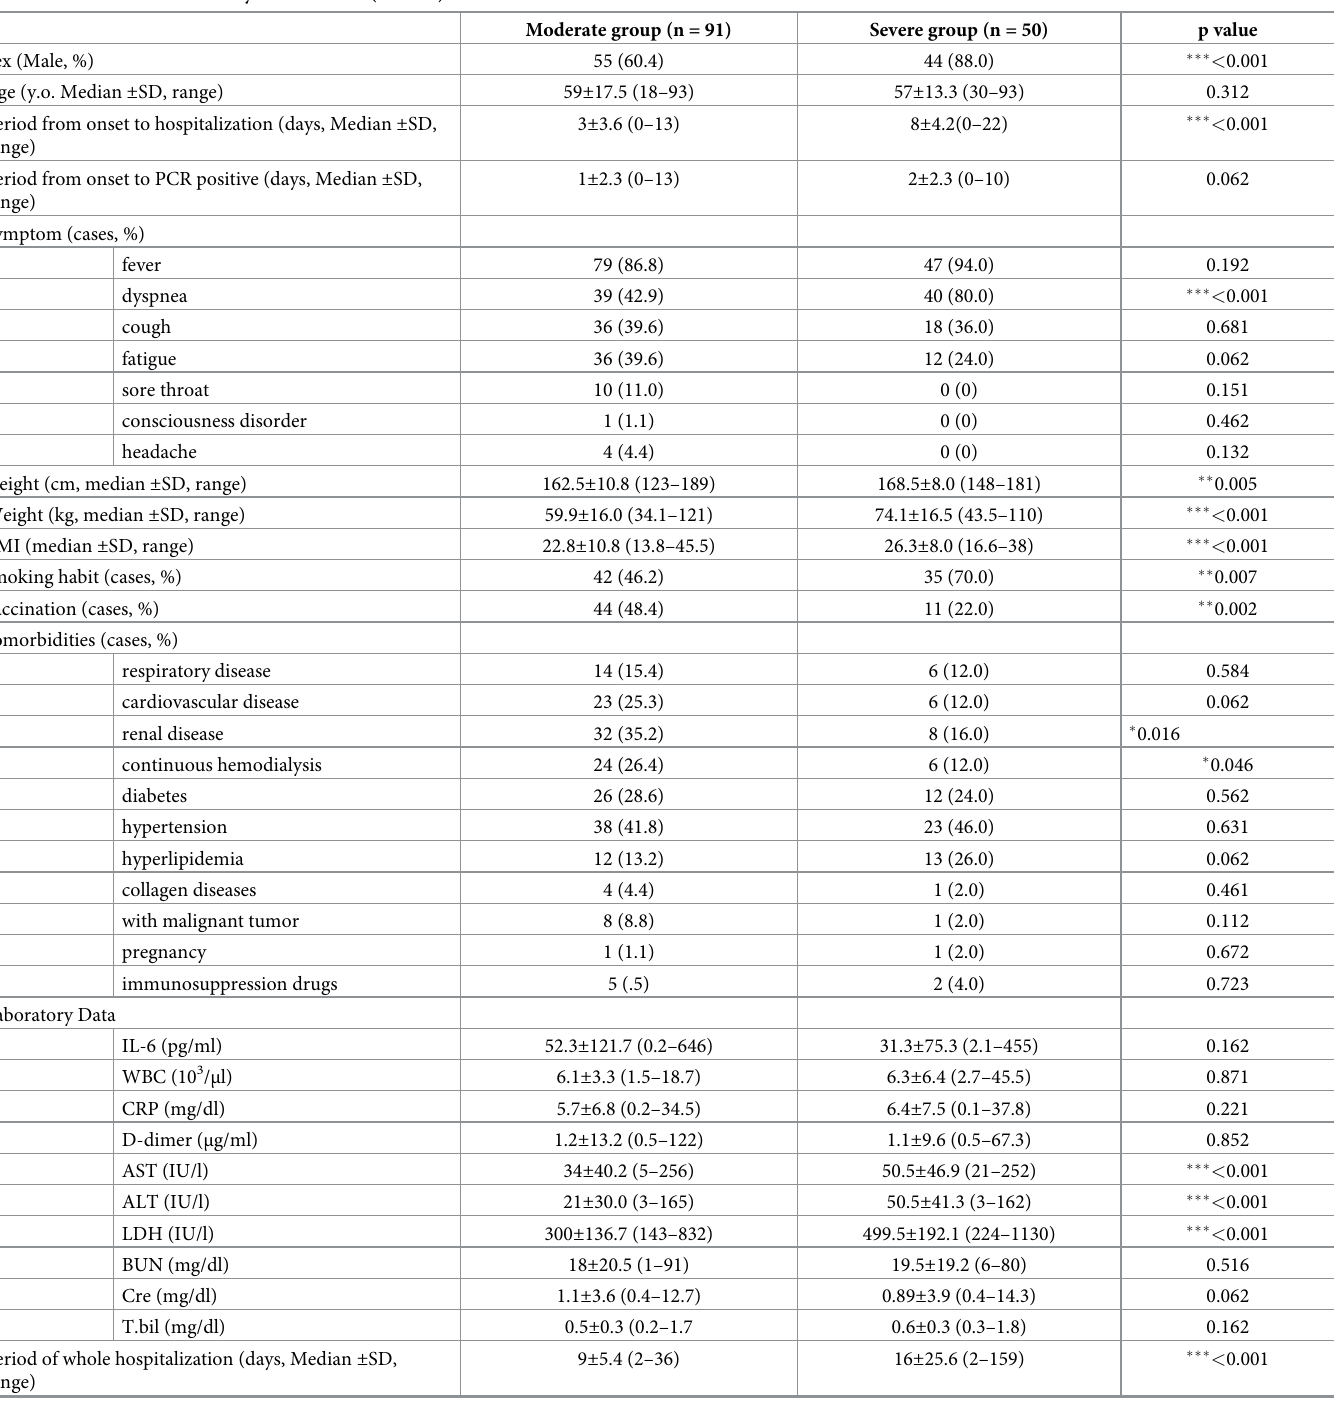
Table 3. Clinical data in severity classification (n =